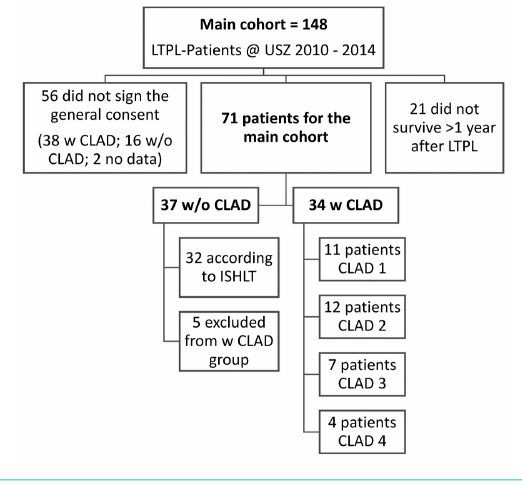
Figure 1: Study flow. We detected 37 patients without and 34 pa- tients with chronic lung allograft dysfunction. Five patients were transferred from the group with chronic lung allograft dysfunction to the group without chronic lung allograft dysfunction due to heart failure, infection, or weight gain. CLAD: chronic lung allograft dys- function; ISHLT: International Society for Heart and Lung